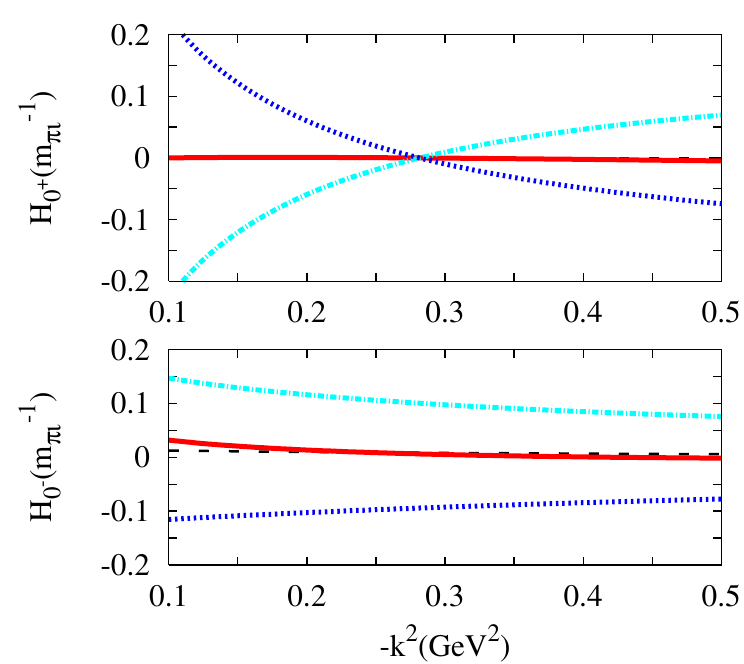
Fig. 3. (Color online) H ( + ) (upper) and H ( − ) (lower) amplitude in a unit m − 1 in terms of − k 2 [GeV 2 ]. Dot-dashed π 0 + 0 + (sky-blue) and dotted (blue) curve are contributions by Born and non-Born term, respectively. Solid (red) curves are final results by Eq.(17). For H ( + ) amplitude, non-Born term does not include the σ ( t ) term. In H ( − ) amplitude, 0 + 0 + dashed (black) curve is the result of Eq.(14) in Ref.[8]. Our result with µ = 0 limit is not indicated because it is nearly indiscernible compared to the solid (red)